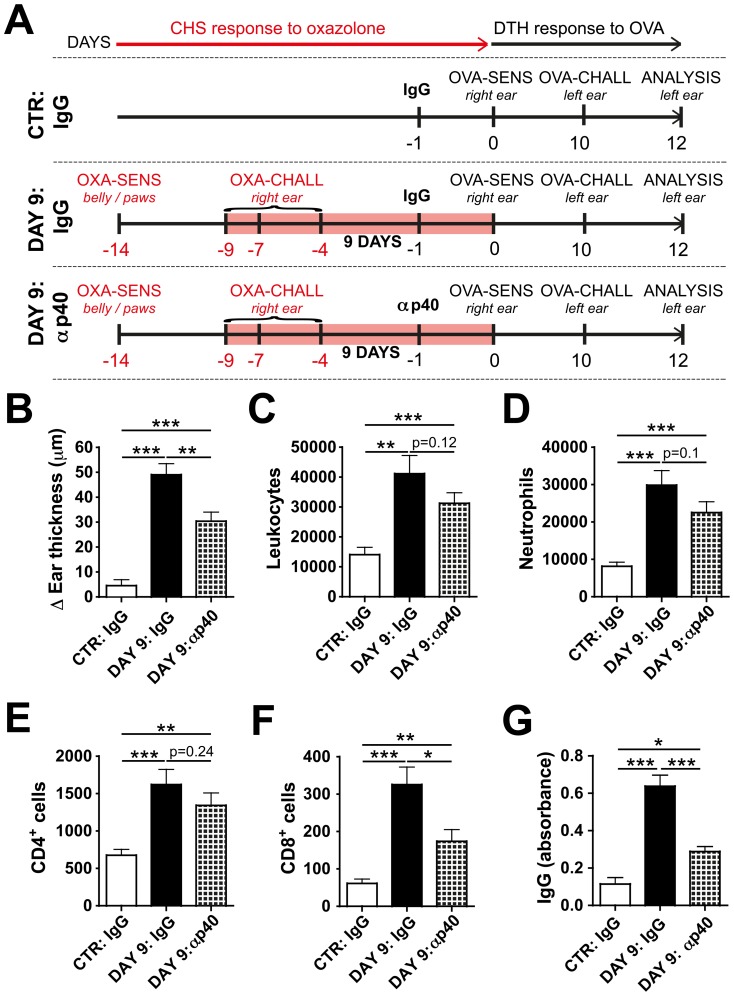
Blockade of IL-12/23-p40 reduces the induction of adaptive immune responses towards OVA in WT mice with DAY 9-inflamed ears.(A) Schematic representation of the experiment: WT mice were grouped into a control (CTR): IgG group, a DAY 9: IgG or a DAY 9: αp40 group. On day -14 mice in the DAY 9: IgG and DAY 9:αp40 groups were sensitized by application of oxazolone (OXA) onto the belly and paws (indicated as OXA-SENS). 5 days later (day -9) a CHS response was induced, by challenging mice with oxazolone on the right ear (indicated as OXA-CHALL). OXA was repeatedly applied onto the right ear on day -7 and day -4, to maintain the inflammatory response. On day -1 the DAY 9:αp40 group was treated with an IL-12/23-p40 blocking antibody (αp40). Mice in the DAY 9: IgG and the CTR: IgG groups were treated with an IgG control antibody (IgG). On day 0 a DTH experiment was initiated in mice from all treatment groups. To this end, all mice were immunized by OVA injection into the CHS-inflamed or control right ear (indicated as OVA-SENS). On day 10, a DTH response to OVA was induced by OVA injection into the left ear (indicated as OVA-CHALL). The strength of the immune response in the left ear was analyzed two days later (day 12). (B) The ear swelling response in the left ear was significantly weaker when mice had been treated with the anti-IL-12/23p40 antibody compared to mice treated with the corresponding isotype control. The Δ Ear thickness is shown, which is defined as the difference between the ear thickness measured at baseline and the ear thickness measured two days after DTH induction. FACS analysis was performed on single-cell suspensions of the DTH-challenged, left ear to quantify leukocyte infiltration. Quantification of (C) total leukocytes (CD45+), (D) neutrophils (CD11b+Gr1+ cells), (E) CD4+CD3+CD45+ T cells and (F) CD8+CD3+CD45+ T cells. (G) Quantification of serum OVA-specific IgG titer. Data from 2 pooled experiments (n = 12–14 mice/group) are shown. *p<0.05; **p<0.01; ***p<0.001.